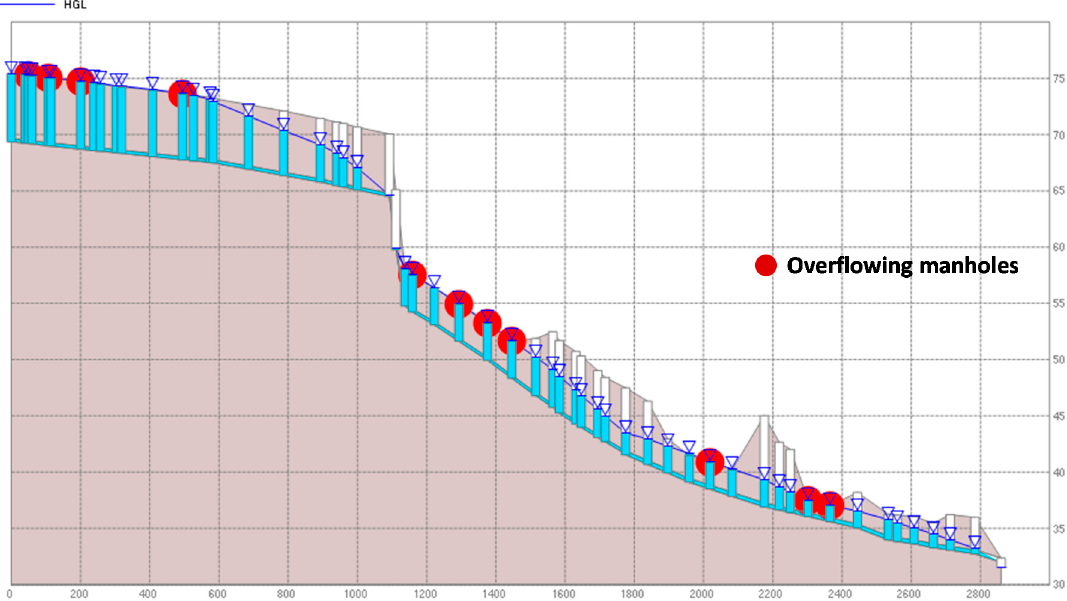
Figure 7. Hydraulic profile plot indicating the locations of SSOs and surcharges that occurred at 3:15 p.m. on 30 October 2010 (units for x- and y-axis are metres)